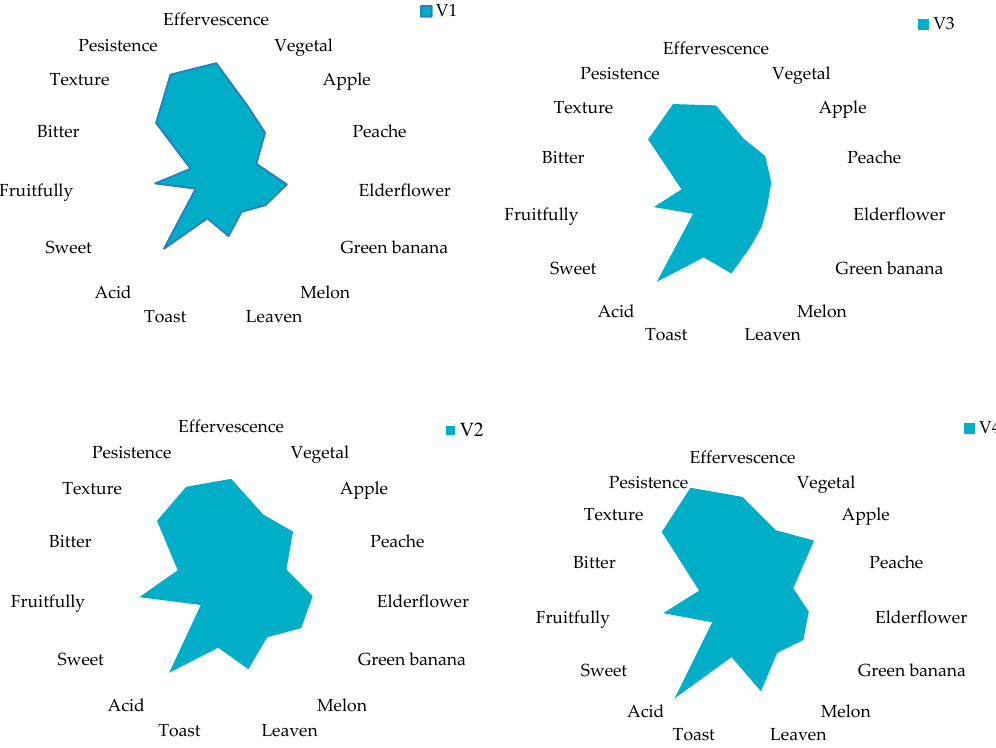
Figure 3. Sensory perception of experimental sparkling wines. The odor intensity of the analyzed parameters was evaluated by means of a hedonistic scale starting with 0—absence to 5—maximum.